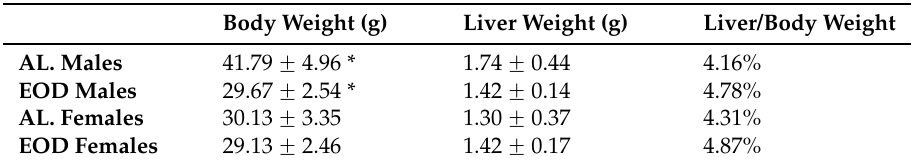
Table 3. Body mass and liver mass of animals on EOD diet and AL fed during 9 months of